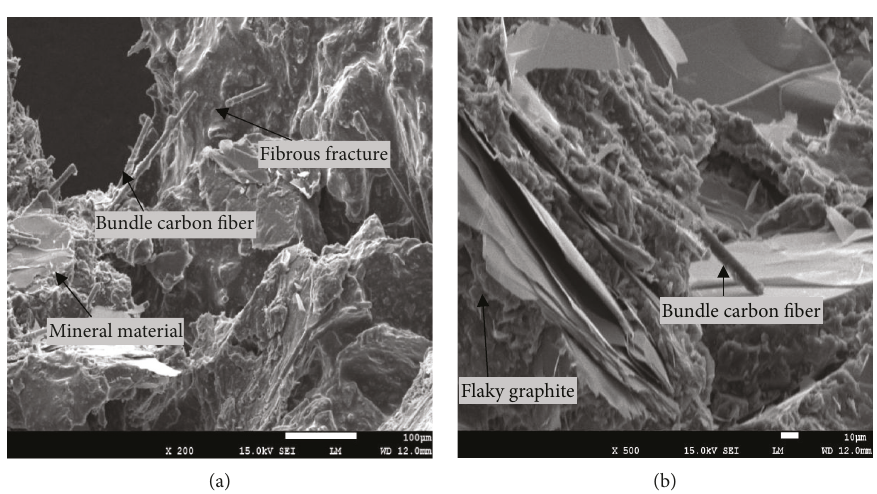
Figure 19: 0.4% carbon fiber +30% graphite CGA-10 micrograph. (a) Asphalt mixture morphology at 200 times. (b) Asphalt mixture morphology at 500